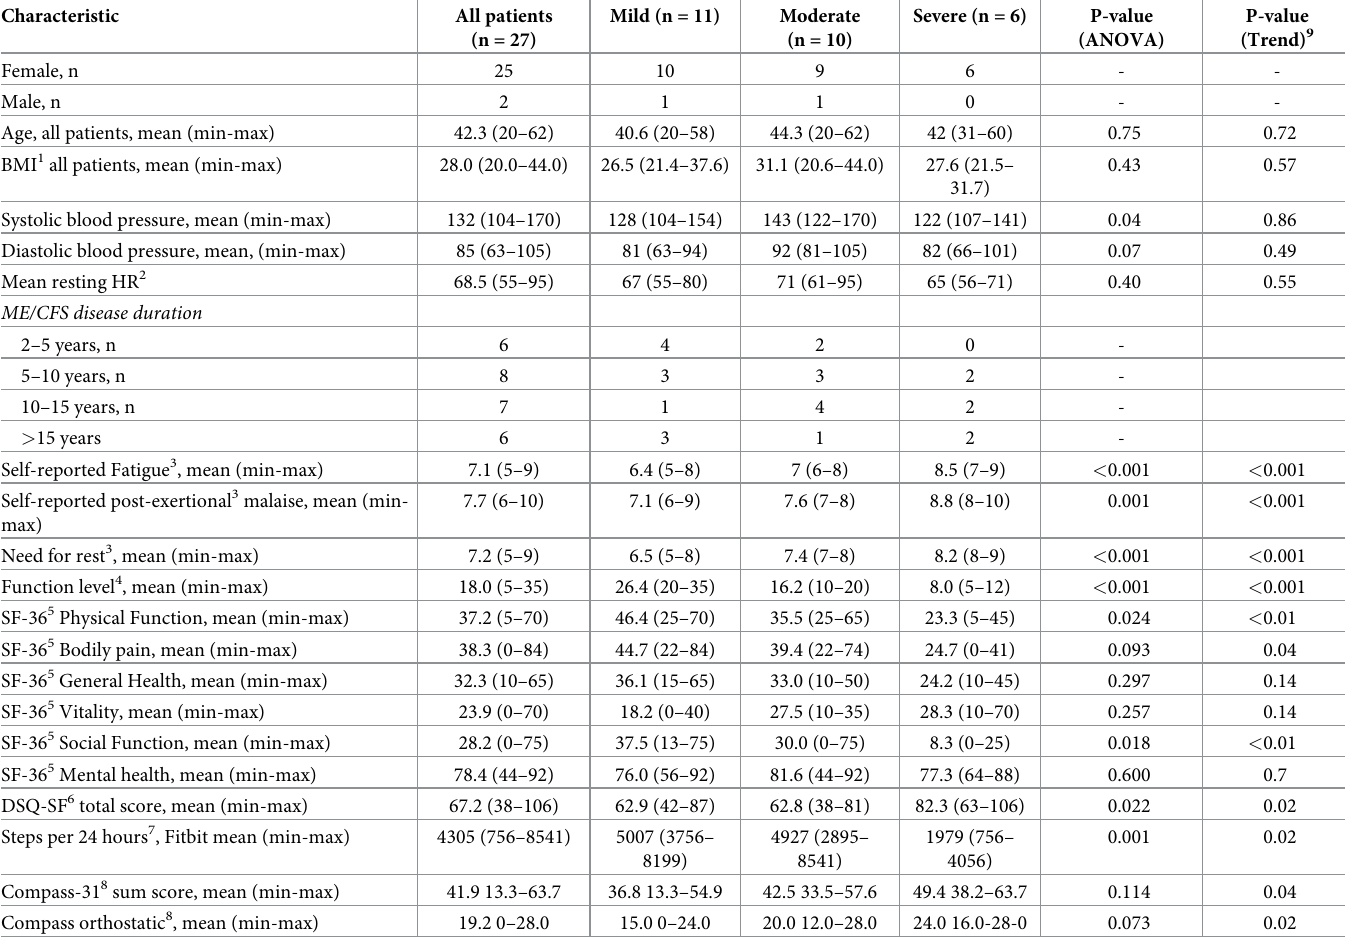
Table 1. Baseline characteristics of the study population, all patients and by severity.